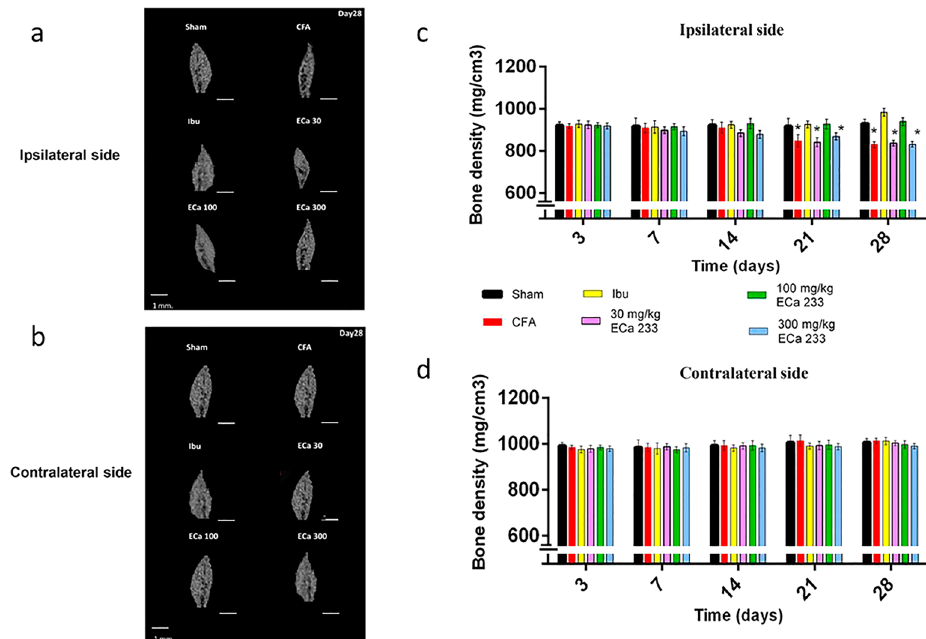
Figure 3. Bone density changes in the condylar head of temporomandibular joints (TMJs) determined by micro–computed tomography (micro-CT). ( a , b ) Sample images of micro-CT scans of the ipsilateral and contralateral TMJs at post–CFA-injection day 28, scale bar = 1 mm. ( c ) Bone density changes on the ipsilateral side of the TMJ’s condylar head. The groups treated with complete Freund’s adjuvant, 30 mg/kg ECa 233, and 300 mg/kg ECa 233 (CFA, 30ECa, and 300ECa groups, respectively) had significant bone density reductions on the ipsilateral side at post–CFA-injection days 21 (CFA [F(5,48) = 60.339, P < 0.05], 30ECa [F(5,48) = 58.931, P < 0.05], 300ECa [(5,48) = 61.135, P < 0.05]) and 28 (CFA [F(5,48) = 49.158, P < 0.05], 30ECa [(5,48) = 48.621, P < 0.05], 300ECa [(5,48) = 47.996, P < 0.05]) compared with the Sham group whereas the Ibu and 100ECa groups did not showed bone density reduction on both days (day 21: Ibu [F(5,48) = 77.678, P = 0.324], 100ECa [F(5,48) = 87.678, P = 0.424]; day 28: Ibu [F(5,48) = 78.728, P = 0.334], 100ECa [F(5,48) = 74.018, P = 0.384]) (mean ± SEM; n = 3/group/time point; *P < 0.05, two-way analysis of variance followed by Fisher’s least significant difference post hoc test). ( d ) Bone density changes on the contralateral side of the TMJ’s condylar head. No difference was observed in bone density on the contralateral side in all groups. (mean ± SEM; n = 3/ group/time